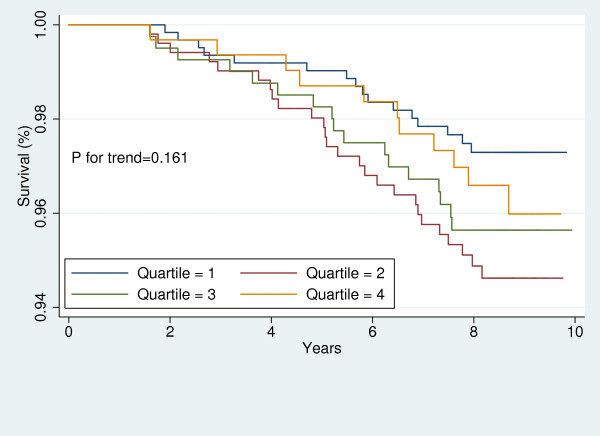
Kaplan-Meier curves for incident CVD across LAP quartiles in men with global CVD risk less than 20%.